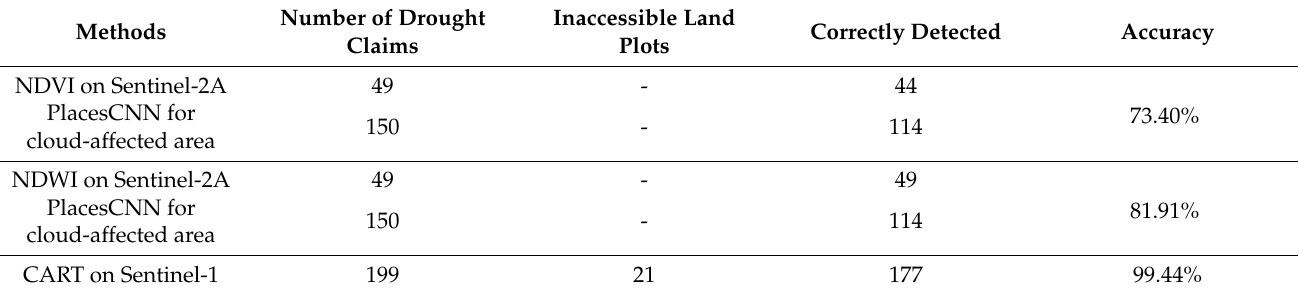
Figure 9. Samples of mobile photos, activation map used by PlacesCNN with ResNet-18 to make its predictions and prediction made from our decision-based method for drought detection. ( a ) Sample from severe drought region. ( b ) Sample from moderate drought region. Table 7. Accuracy assessment using verified mobile images for drought detection with the integration of mobile images with Sentinel-2A images in cloud cover areas and overall accuracy of the CART method on Sentinel-1 SAR GRD images.